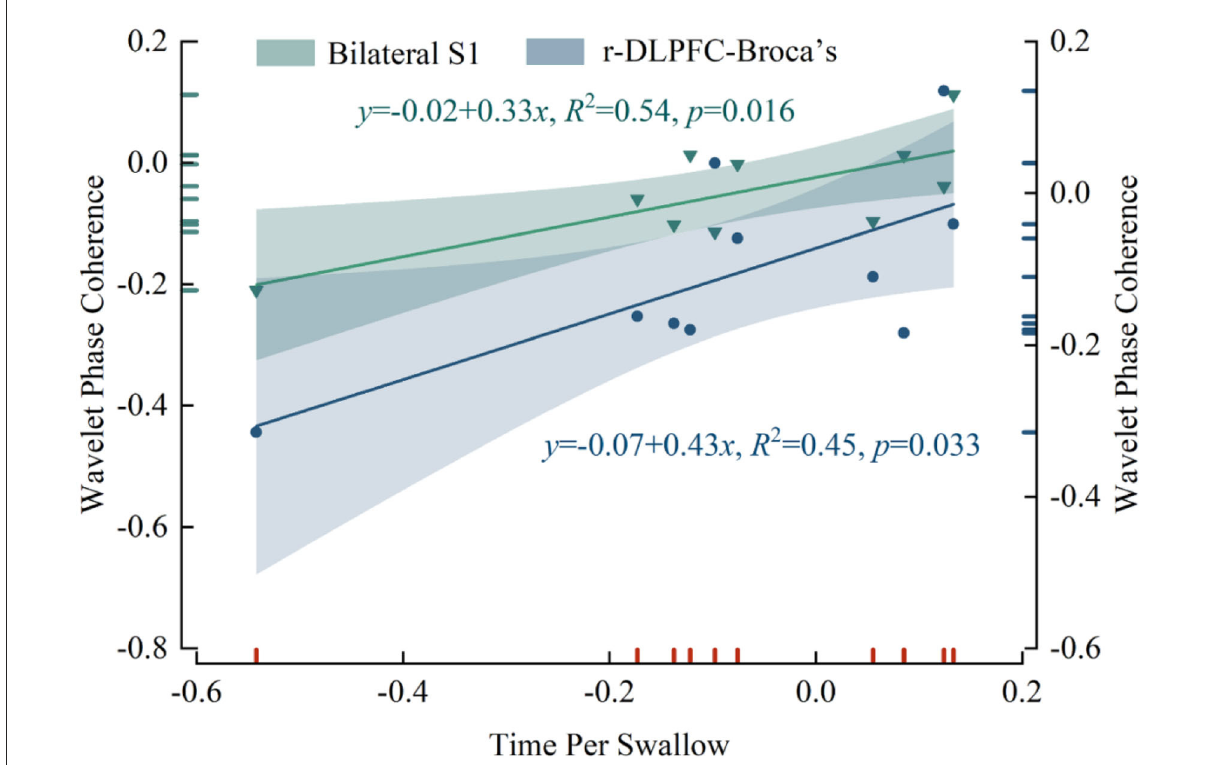
FIGURE5 The correlation results in WPCO values and the shortened time per swallow after mPES. WPCO, wavelet phase coherence; mPES, modified pharyngeal electrical stimulation; r, right hemisphere; S1, primary somatosensory cortex; DLPFC, dorsolateral prefrontal cortex; Broca’s, Broca’s